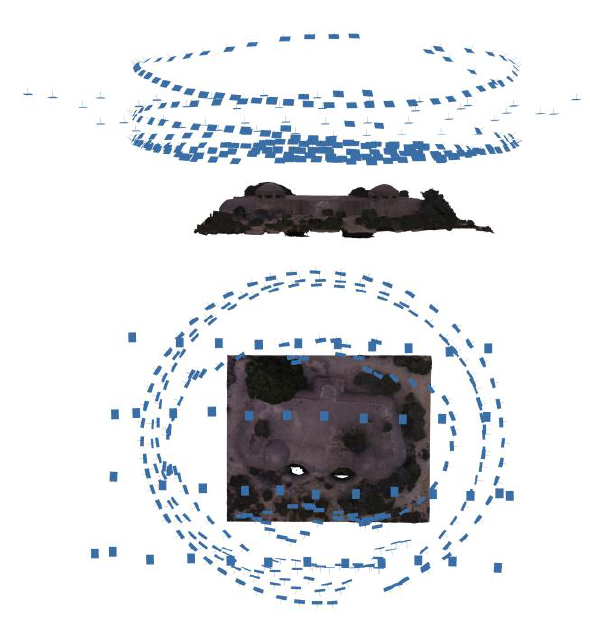
Figure 7. Position of the cameras around to the model